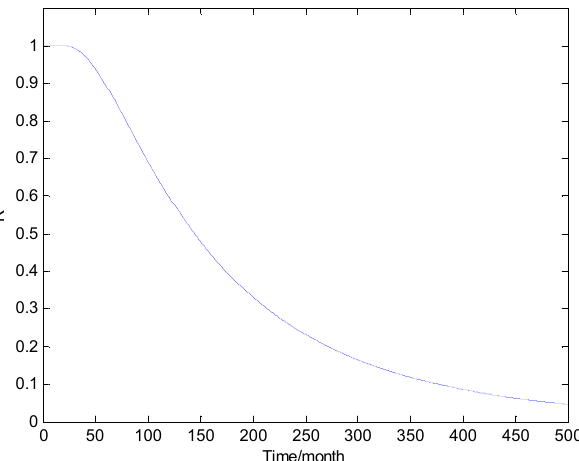
Figure 1. Momentum wheel reliability curve based on lubricant residual amount.